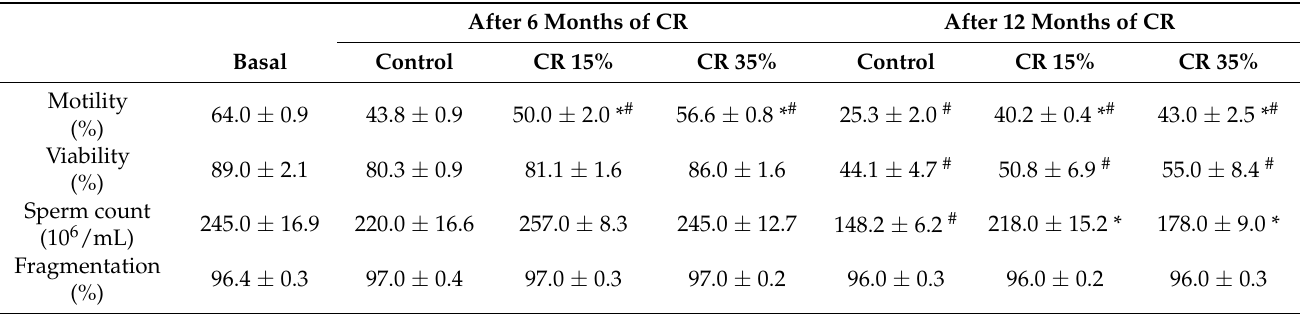
Table 3. Effect of CR on sperm quality in aged male Wistar rats. After 6 Months of CR After 12 Months of